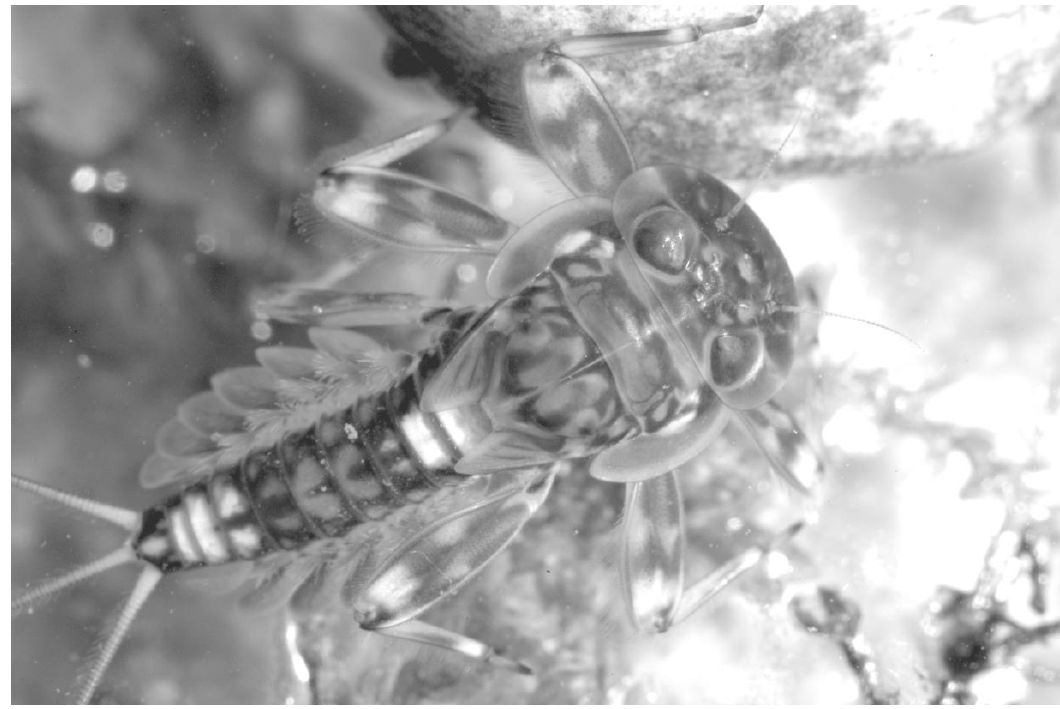
Figure 1. Dorsoventral flattening of an Ecdyonurus (Ephemeroptera: Heptageniidae) nymph (Photo Roberto Messori; reproduced with permission from the author).